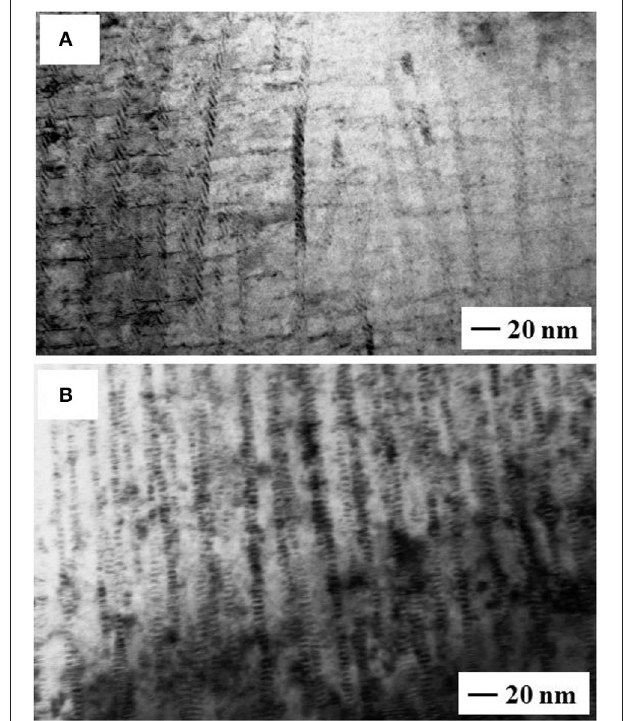
FIGURE 15 | Cross-sectional TEM images of YBCO films with (A) BSO nanocolumns and (B) BSO nanocolumns and Y 2 O 3 nanoparticles deposited by surface modified target method. Reproduced from Jha et al. [ 130], with the permission from IEEE Publishing.